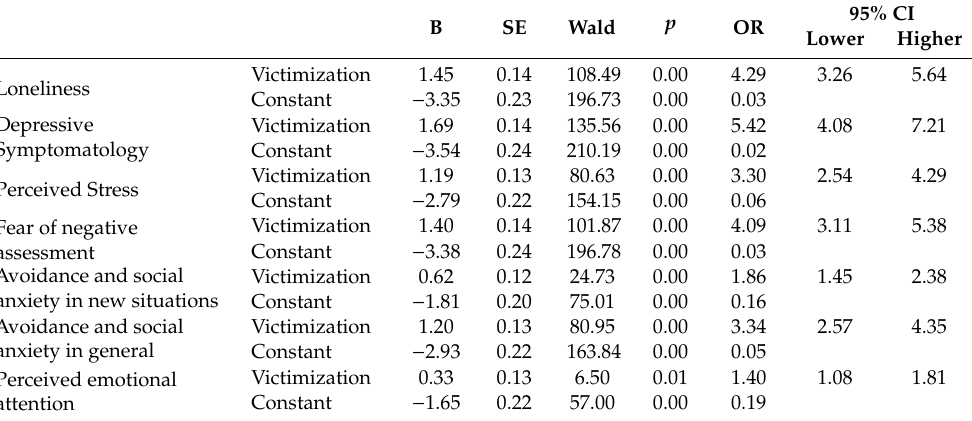
Table 6. Logistic regression with traditional victimization as a predictor of high